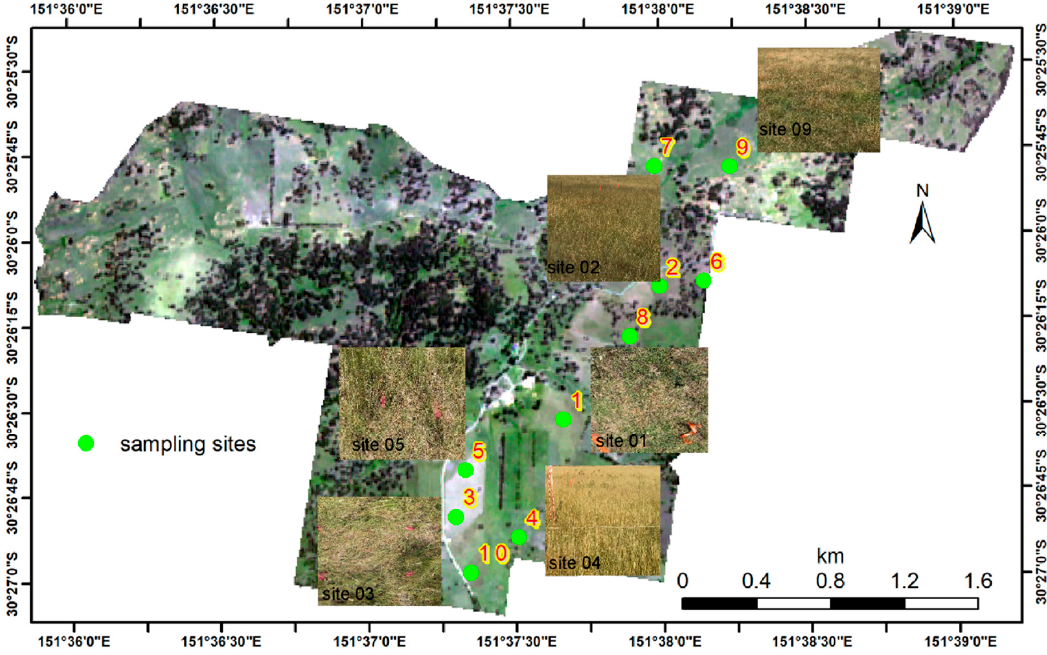
Figure 1. True colour (RGB) Sentinel-2A image (24 February 2017 acquisition) of study site with some photo insets, and the central location point of the ten sampling sites (indicated by green circles and are not drawn to scale). Each sampling site was 900 m 2 .